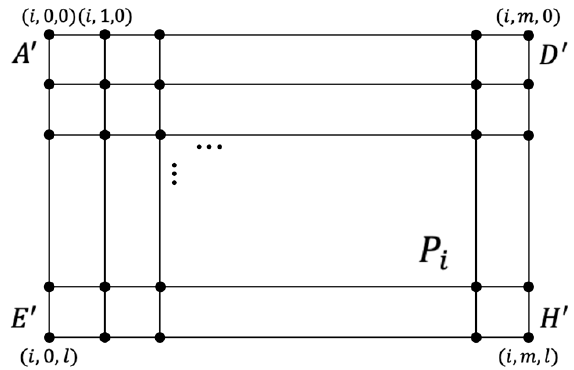
Figure 2. Plan of Coordinate System.